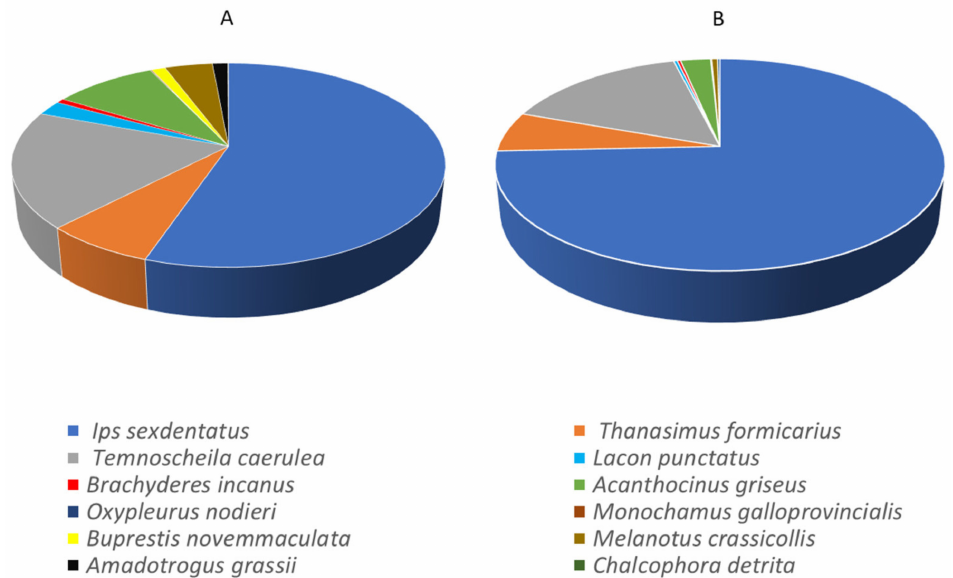
Figure 5. Percentages of I. sexdentatus and non-target beetles > 8 mm caught in standard traps ( A ) and modified traps ( B ) baited with the I. sexdentatus aggregation pheromone in the study site (Municipality of Grosseto, Tuscany, Italy) during